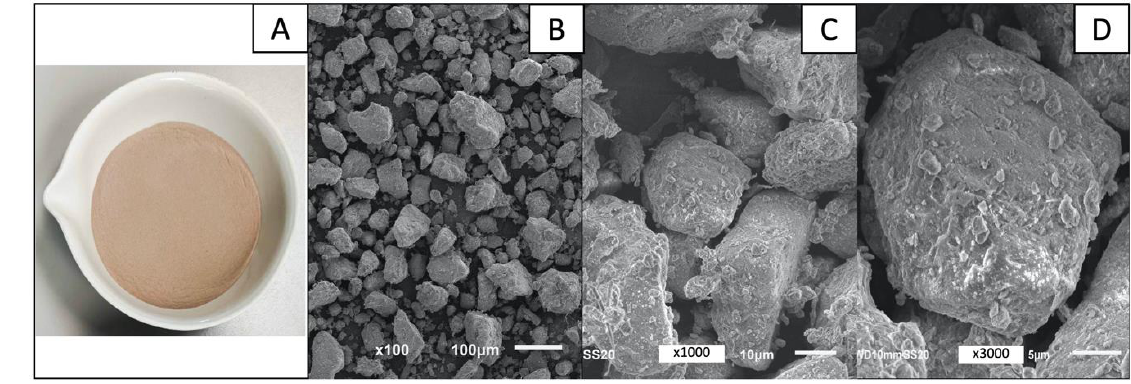
Figure 2. ( A ) Local soil ballast after grinding and sieving and SEM images at ( B ) 100× ( C ) 1000× and ( D ) 3000× magnifica- tion.